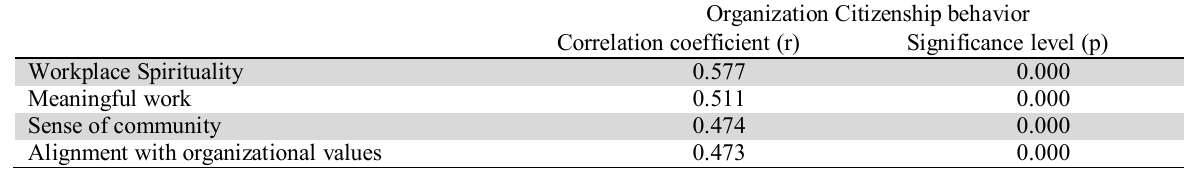
The results of correlation between OCB and workplace Spirituality Dimensions